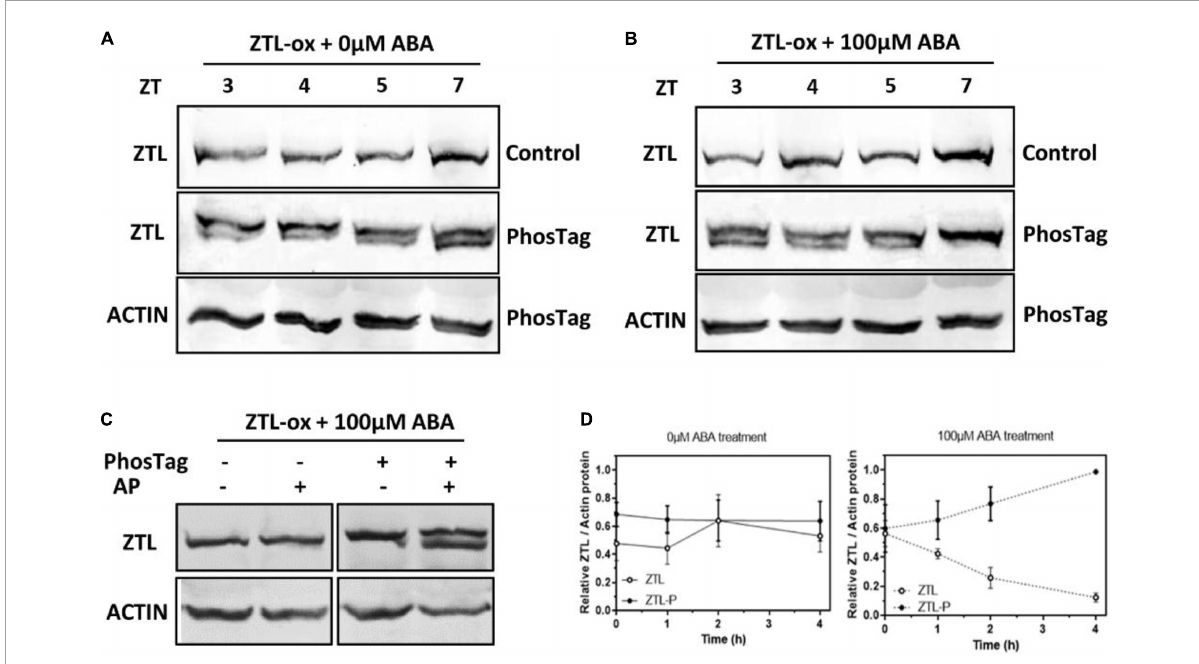
FIGURE5 ABA promotes ZTL phosphorylation. (A,B) Immunodetection of ZTL protein isoforms with α -GFP antibody in ZTL-ox plants. Seedlings were entrained under LgD cycles, and were treated with (B) or without (A) 100 µ M ( ± ) ABA at ZT3. Then samples were collected at the indicated ZT. Total protein extracts were resolved in SDS-PAGE gels with (middle, down) or without (up) Phos-tag. ACTIN protein was used as a control (down). (C) Immunodetection of ZTL isoforms in ZTL-ox seedlings with 4-h 100 µ M ( ± ) ABA treatment. Seedlings were entrained under LgD cycles, and were treated with 100 µ M ( ± ) ABA at ZT3. Then, samples were collected at ZT7. Protein extracts were incubated at 30 ◦ C for 1 h in alkaline phosphatase (AP) buffer with or without alkaline phosphatase. Then protein extracts were resolved in SDS-PAGE gels with (right) or without (left) Phos-tag. The experiments were repeated three times with similar results. (D) Quantification of non-phosphorylated and phosphorylated ZTL protein abundances in (A,B) . Means ± SE of four independent experiments are represented relative to the maximum value and normalized to ACTIN